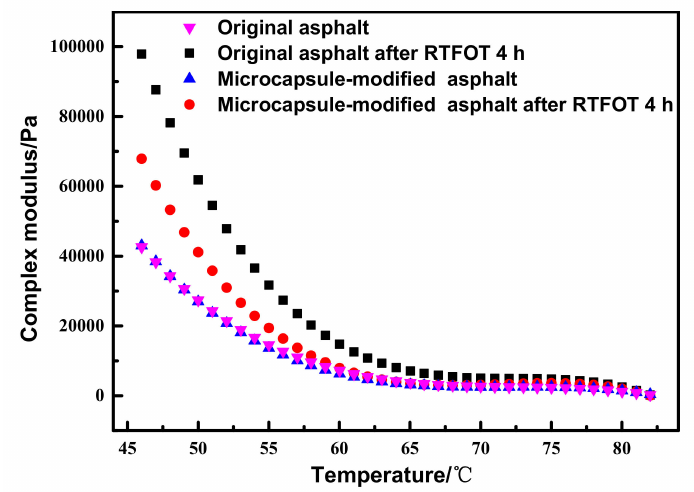
Figure 11. The complex modulus of different asphalt samples before and after Rolling Thin Film Oven Test (RTFOT) aging.